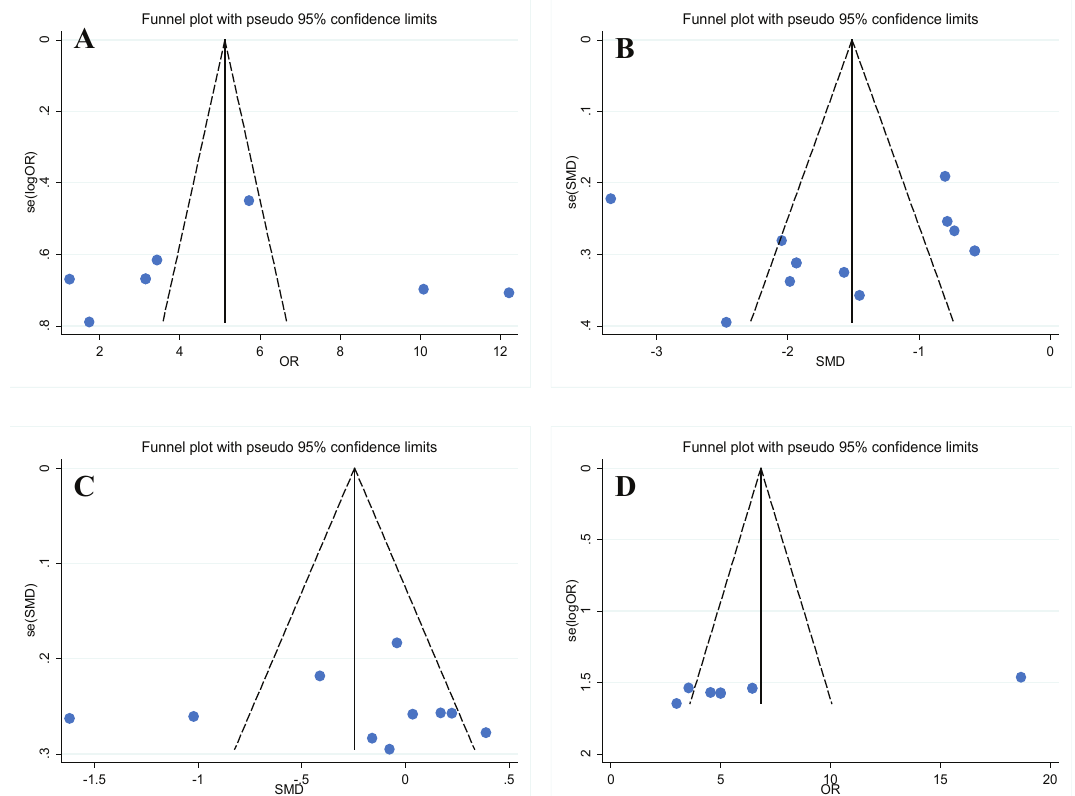
Figure 7: Funnel plot for evaluation the publication bias.(A: total efficacy; B: 24h urinary protein; C: serum creatinine; D: tripterygium glyco- sides related